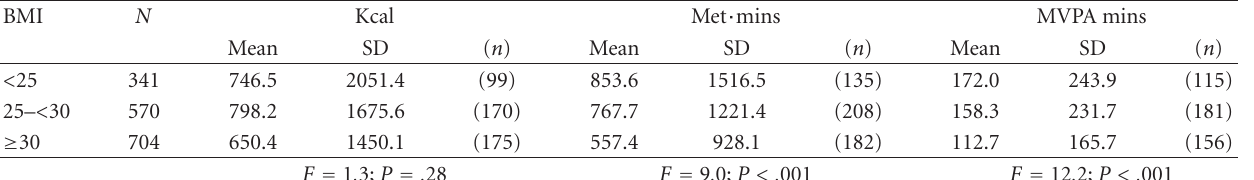
Table 2: Means and one-way ANOVA results for each of the three methods of assessment.